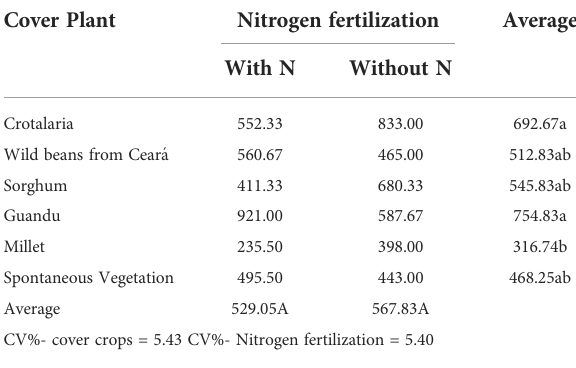
TABLE 2 Spore density (n°/50 ml ) of cover crops after maize cultivation, with and without nitrogen fertilization in top-dress, in maize. Log transformed data (x +